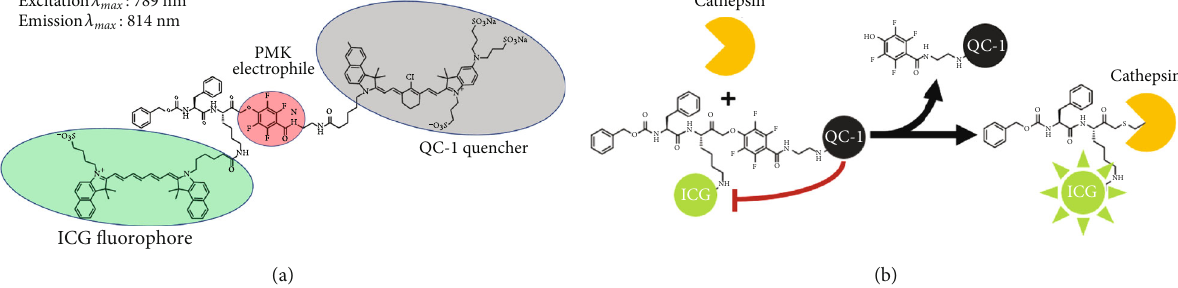
Figure 1: Structure, optical properties, and mechanism of action of VGT-309. (a). VGT-309 consists of a cathepsin-targeted PMK electrophile coupled to an ICG fl uorophore and QC-1 quencher. Its maximum absorption and emission wavelengths are 745 nm and 820nm, respectively. (b). Mechanism of action of VGT-309. The ICG fl uorophore is quenched by the QC-1 quencher until it is cleaved upon covalent binding by cysteine